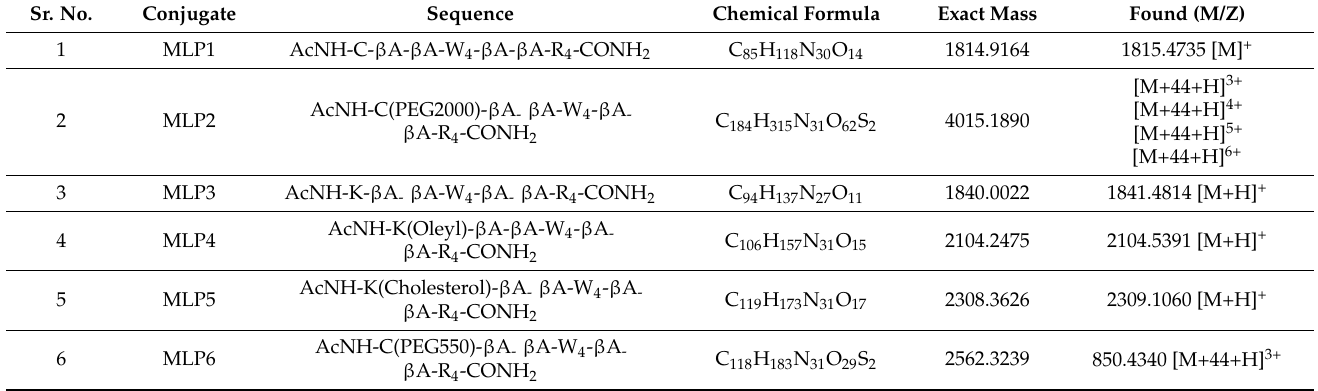
Table 1. Synthesized MLPs and MALDI-TOF/ESI-TOF